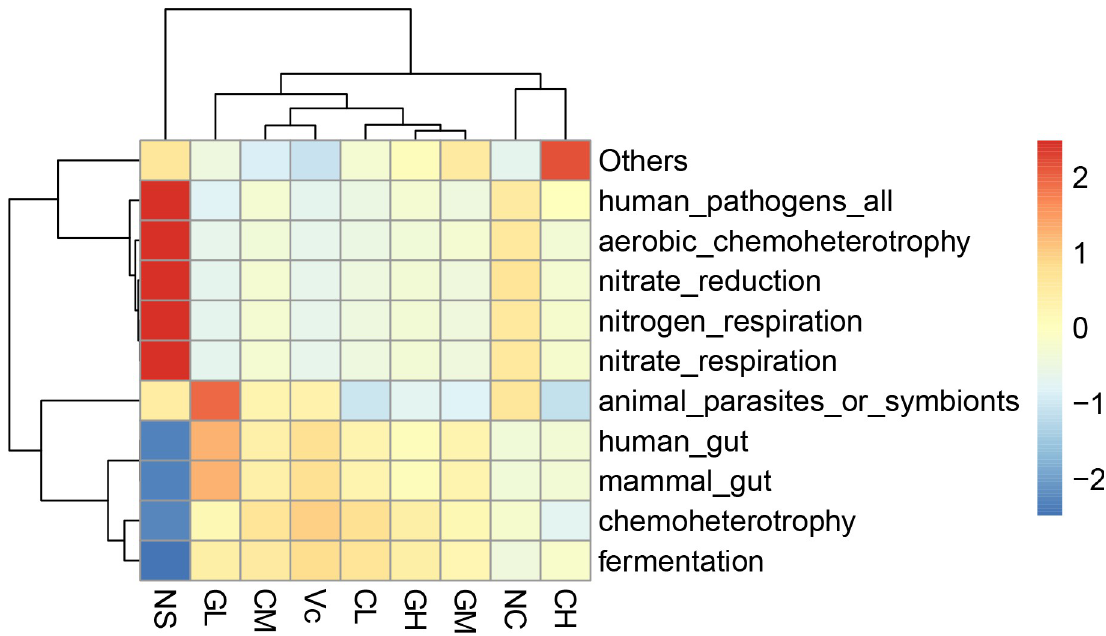
Fig 6. Functional prediction analysis results. Different colors represent the level of correlation between groups and functions. The redder the color, the stronger the correlation; the bluer the color, the weaker the correlation. NC: Normal control; NS: Negative control; Vc: Positive control; CL, CM, CH represents low-, middle-, high-concentration cow whey protein intervention group, respectively. GL, GM, GH represents low-, middle-, high-concentration goat whey protein intervention group, respectively.